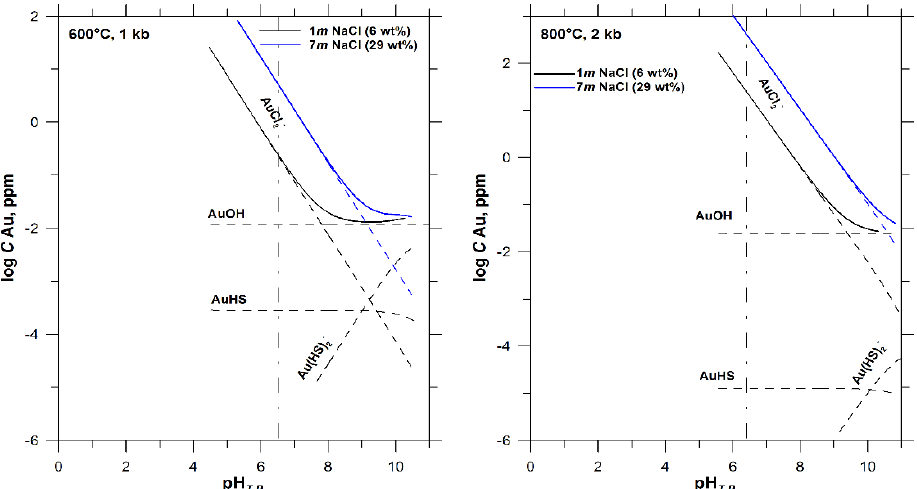
Figure 5. Gold solubility as a function of pH T , P . The concentration of dissolved sulfur is 0.01 m, the redox conditions are controlled by the Ni/NiO buffer. Lines are calculated using the results of the present study: solid lines — total dissolved Au, and dashed lines — individual aqueous complexes. The vertical dashed-dotted line corresponds to neutral pH. Thermodynamic data for Au – OH and Au – HS complexes were adopted from Akinfiev and Zotov [35].